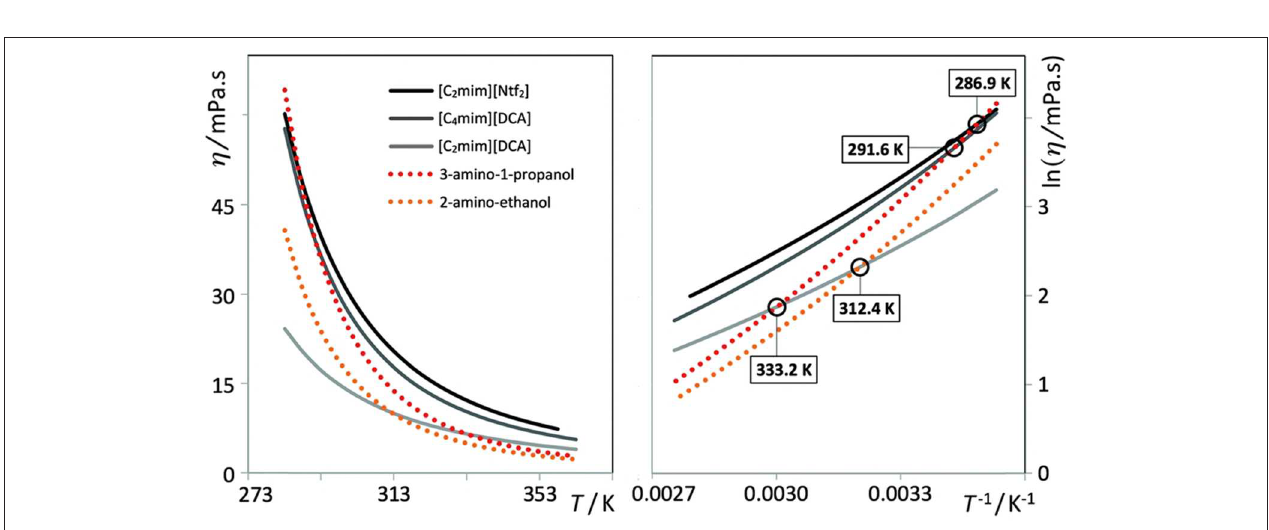
FIGURE 2 | Experimental viscosity data, η /mPa · s, of the three ILs ([C 2 mim][Ntf 2 ], [C 2 mim][DCA], and [C 4 mim][DCA]) and two molecular solvents (2AE and 3AP) studied in this work as a function of temperature. The right-hand plot shows the logarithm of viscosity as a function of the reciprocal of temperature. The circles indicate the viscosity cross-over temperatures. (Reprinted from Tariq et al., 2015 with permission from Royal Society of